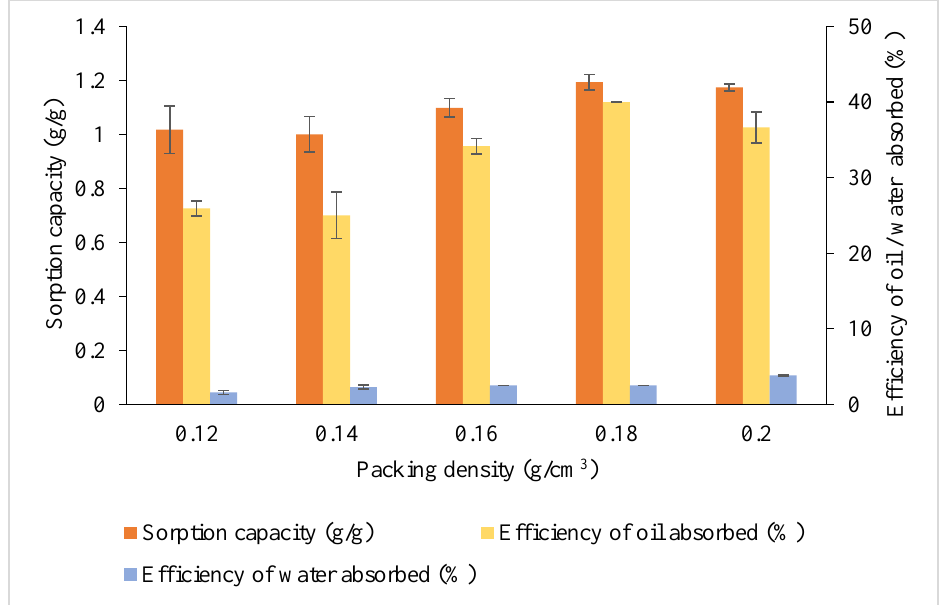
Figure 8. Effects of varying packing densities (g/cm 3 ) on sorption capacity and oil/water absorption efficiency. Error bars indicates SD for the three replicates.